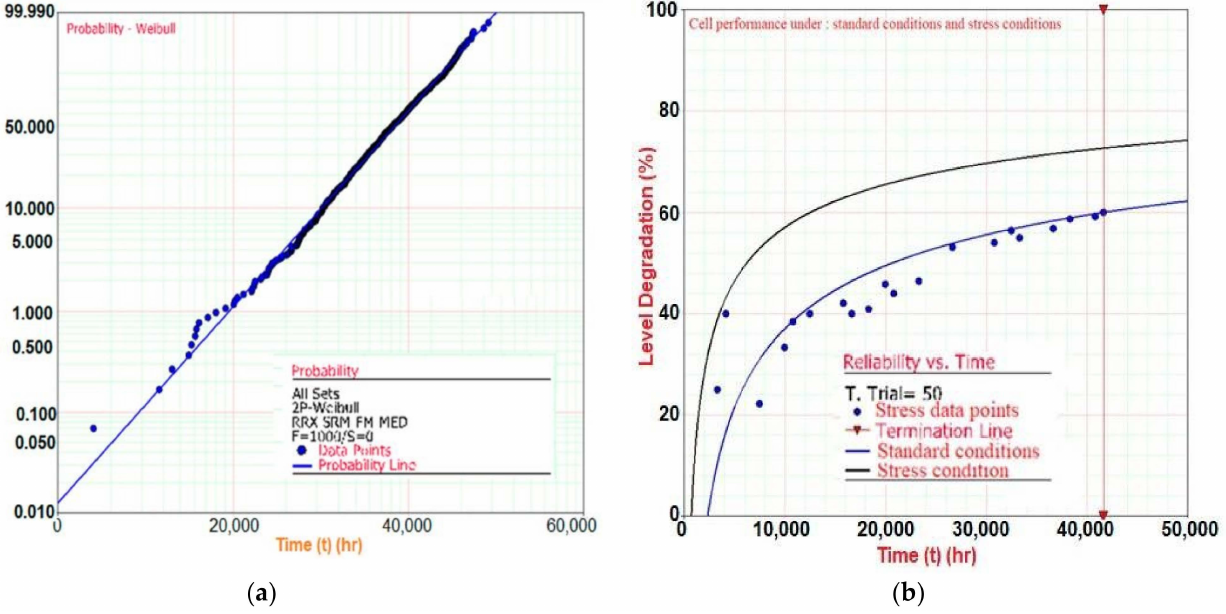
Figure 21. ( a ) Weibull repartition for the studied solar cell lifetime; ( b ) solar cell degradation degree under standard and stress conditions